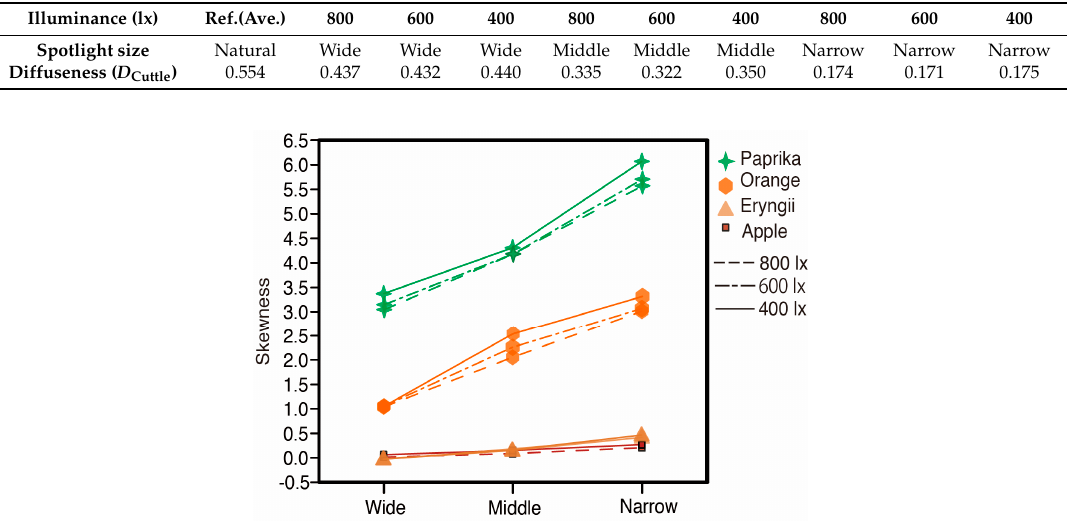
Table 1. Illuminance, spotlight size, and diffuseness for different viewing conditions.